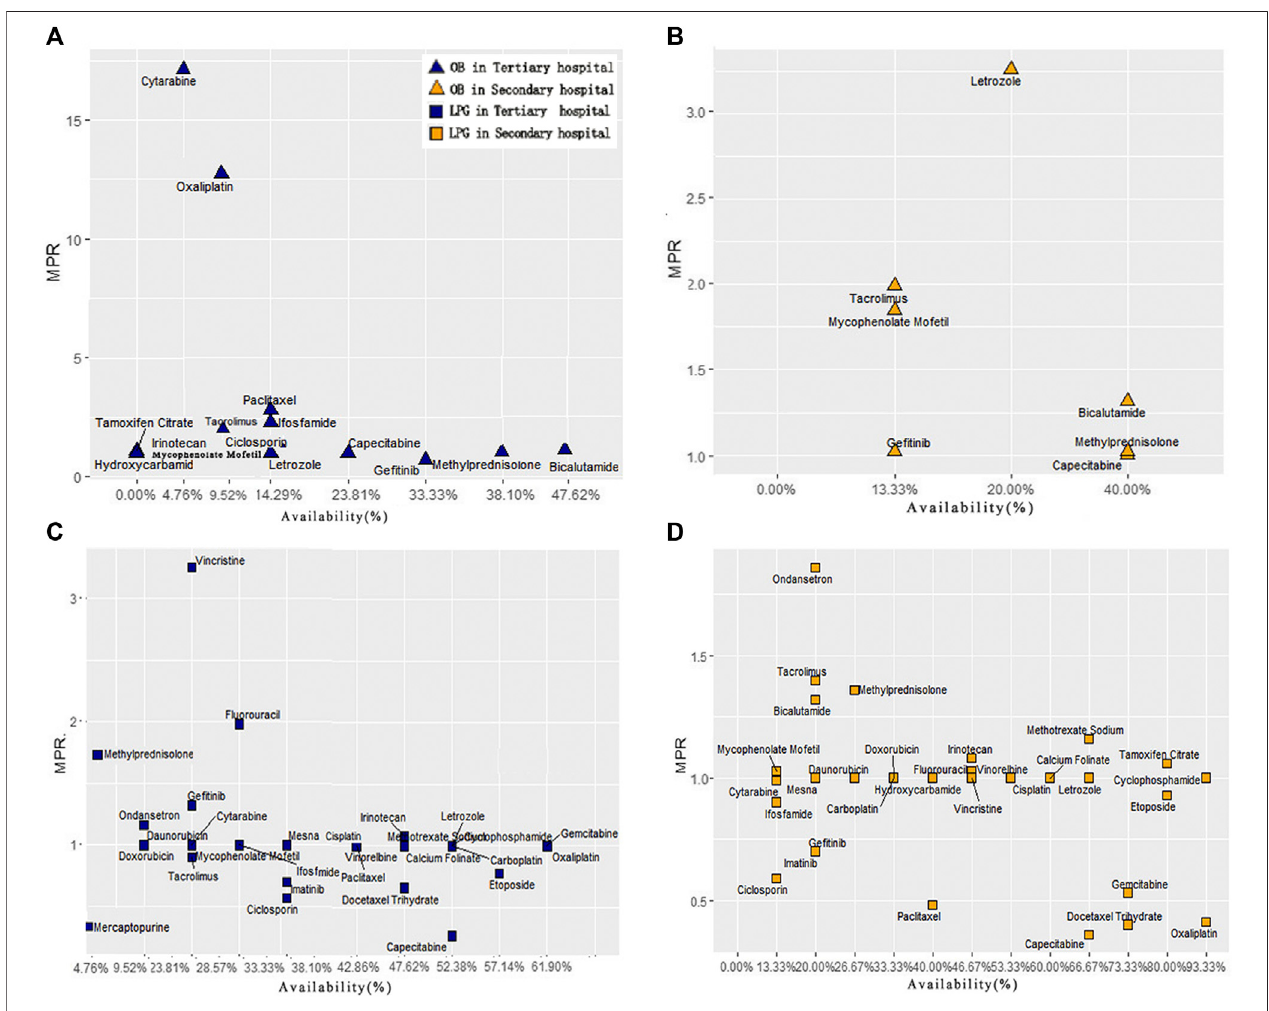
FIGURE3| ComprehensiveanalysisofanticancermedicineavailabilityandMPRinHubeiProvince. (A) ScatterplotofOBsavailabilityandMPRintertiaryhospitals. (B) Scatter plot ofOBs availability and MPR in secondary hospitals. (C) Scatter plot of LPGs availability and MPR in tertiary hospitals. (D) Scatter plot ofLPGs availability and MPR in secondary